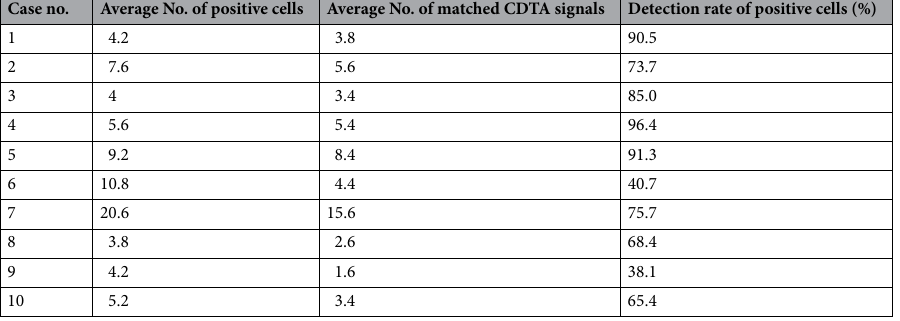
Table 2. Detection rate of positive cells for each case.